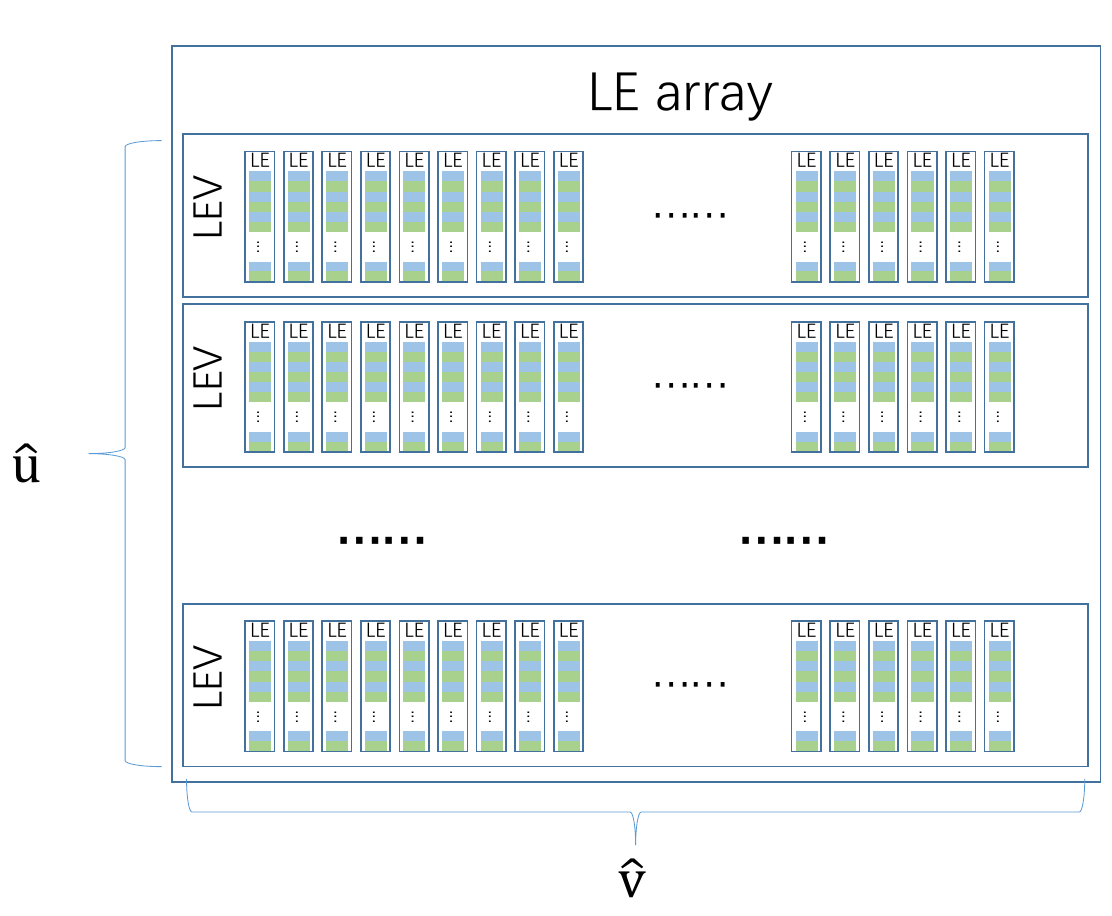
Figure 5. Structure of LE